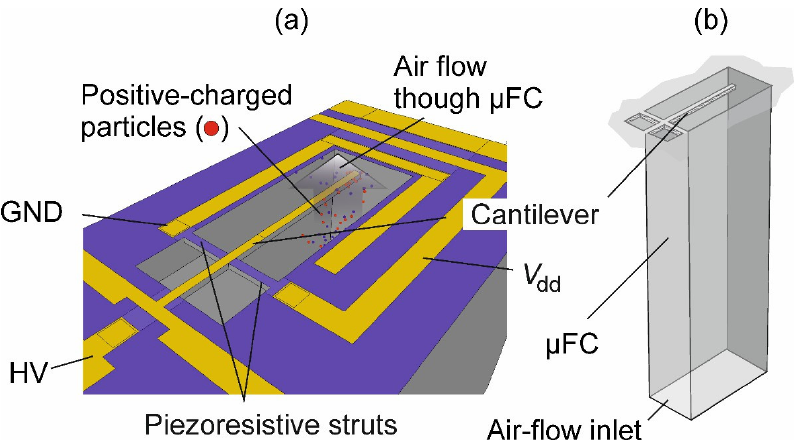
Figure 2. ( a ) Schematic of a micro cantilever with released piezoresistive struts (as strain gauge supplied by V dd ) located in a micro-fluidic channel (µFC) guiding a particle-laden air flow. The cantilever is negatively polarized using a variable direct current (dc)-voltage (HV) with respect to the µFC walls, which are on ground potential (GND). In ( b ) a schematic of the complete µFC is displayed with the air-flow inlet at the bottom of the MEMS die.